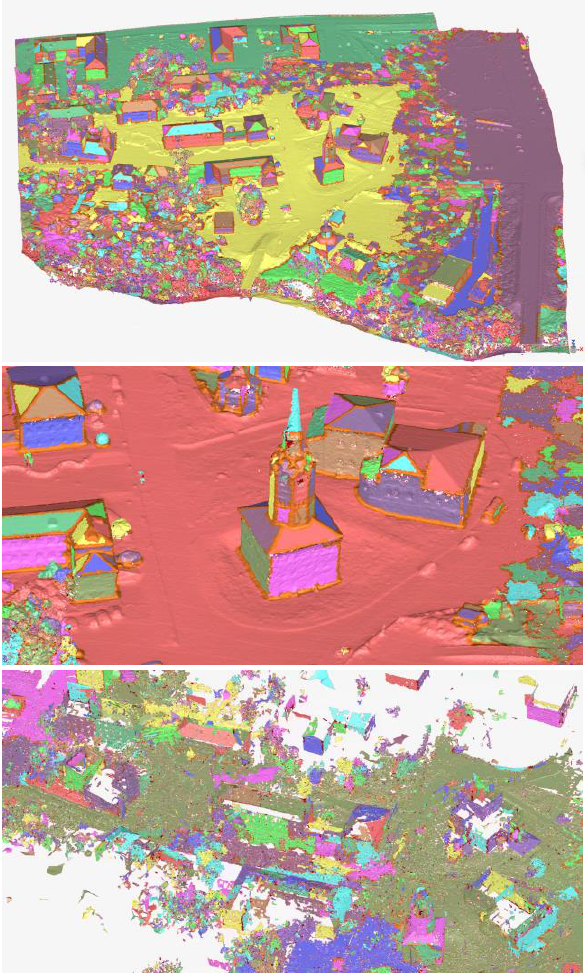
Figure 8 . Quality of feature-based semi-automated segmentation on UAV spatial triangulated data (above) and detail on the Heritage qualities of a monumental unit